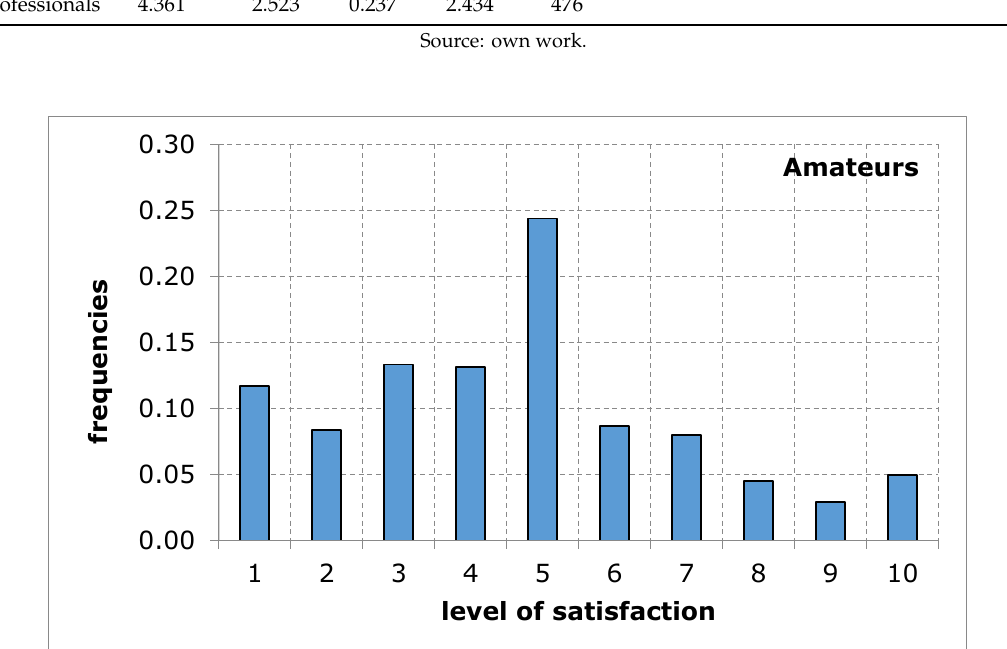
Figure 9. Use of a sports and recreation facility for competitive sport purposes, in the opinion of service recipients (amateurs). Source: own work.